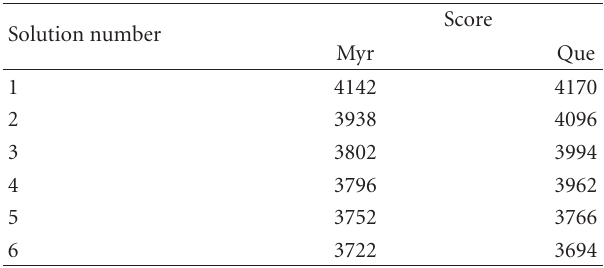
Table 1: Docking results of Kp DnaB with Myr and Que from